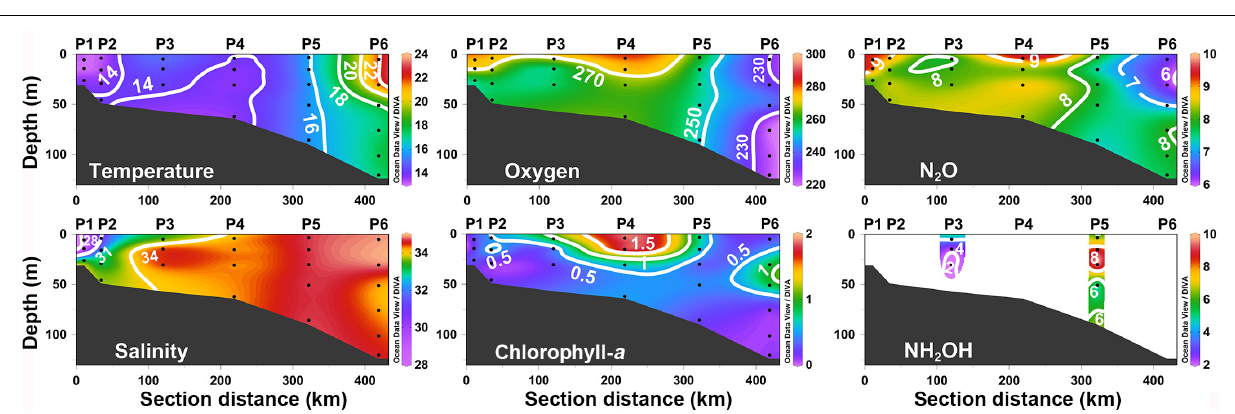
FIGURE 5 | The vertical distributions of temperature ( ◦ C), salinity (psu), dissolved oxygen ( µ mol L − 1 ), chlorophyll- a ( µ g L − 1 ), N 2 O (nmol L − 1 ), and NH 2 OH (nmol L − 1 ) along section